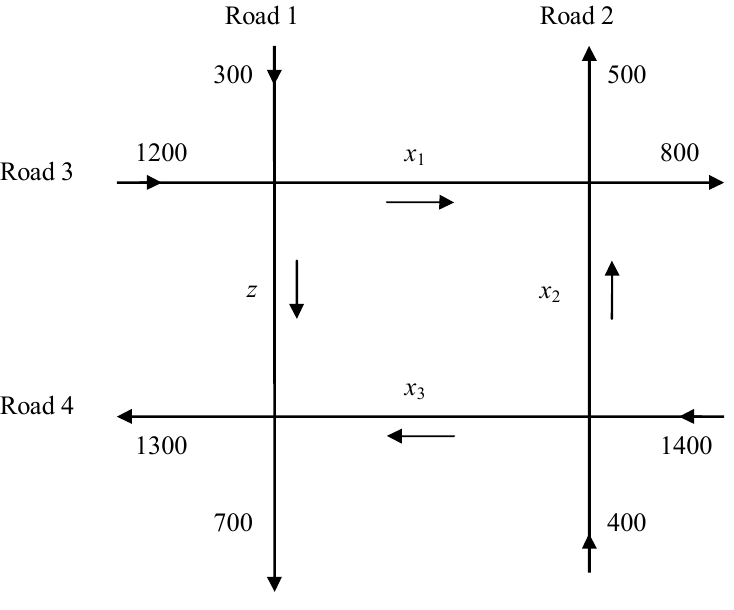
Figure 1. The downtown traffic flows of four